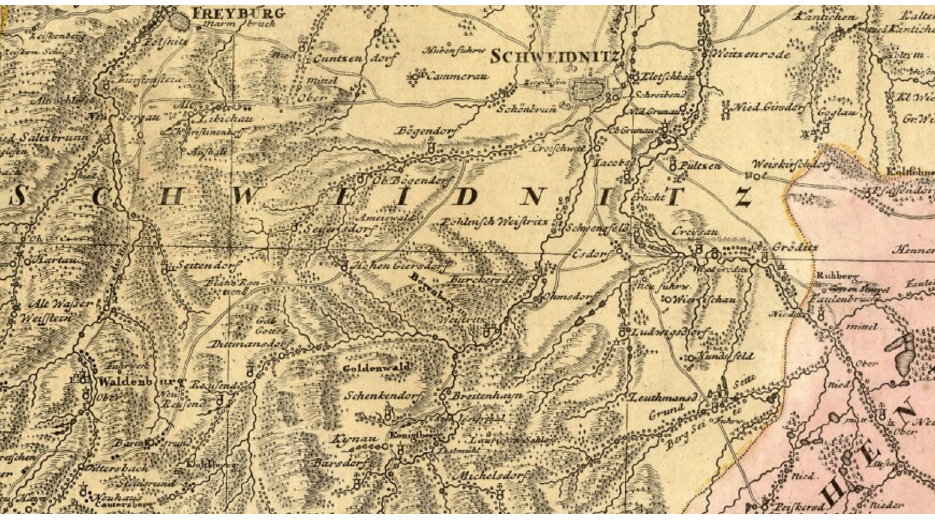
Fig. 4. Section of the Sudetes edge south of Świdnica on the map of the Duchy of Świdnica by J.W. Wieland and M. Schubarth from the Atlas of Silesia (source: www.mollova mapova